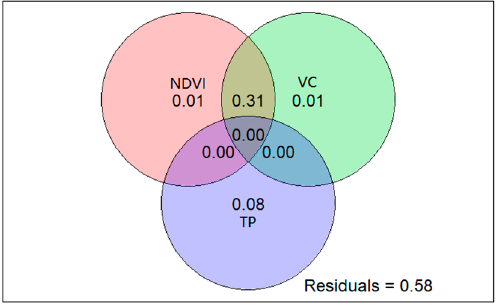
Figure 10. Contribution rates of NDVI, VC, and TP to LES. NDVI represents normalized differential vegetation index; VC represents vegetation coverage; TP represents land surface temperature.